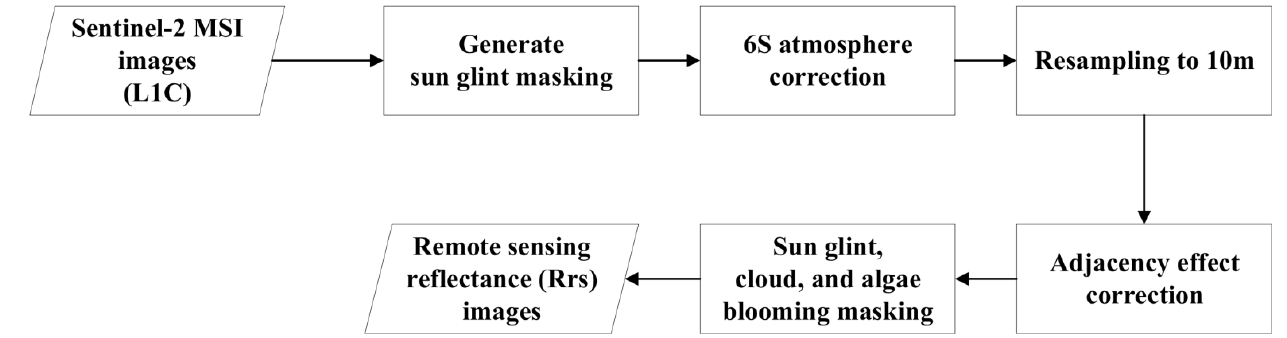
Figure 2. Flowchart of the methodology used to process Sentinel-2 images for the retrieval of